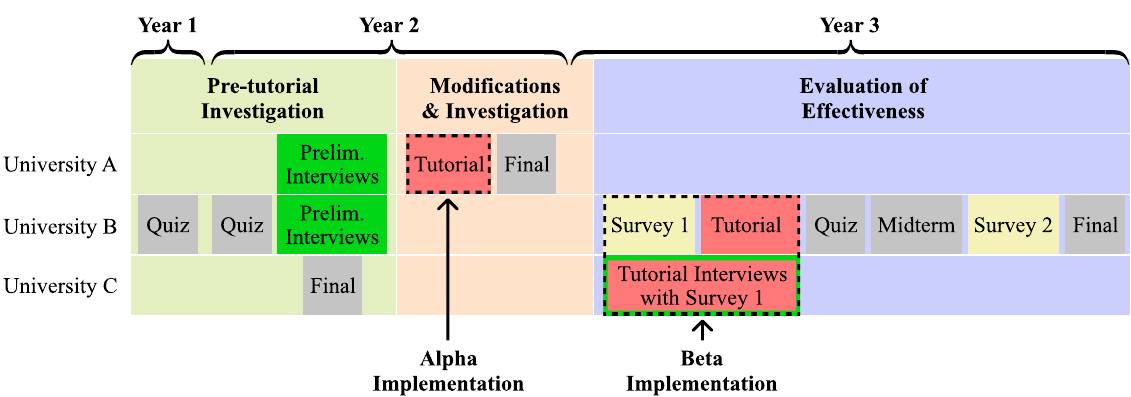
FIG. 3. Timeline for research, tutorial development, and evaluation. The three main phases of the project are identified in the column header and the different years of the project are shown with brackets above the table. Each quiz, midterm, and final included a change-of- basis question (similar to the one in Fig. 4). The tutorial was not repeated at University A in year 3 due to a change in instructor. All data collection and tutorial implementation was completed prior to the 2020